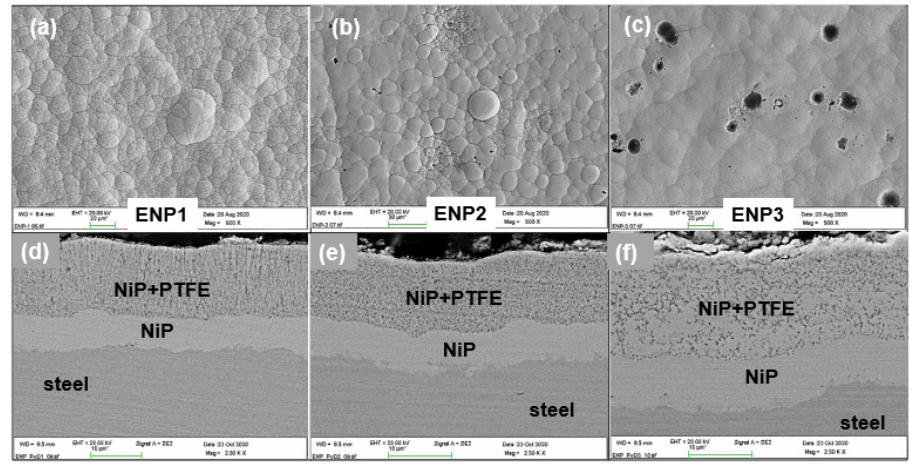
Figure 1. SEM micrographs showing morphology ( a – c ) and cross-sectional microstructure ( d – f ) of the deposited ENP1, ENP2 and ENP3 duplex coatings.